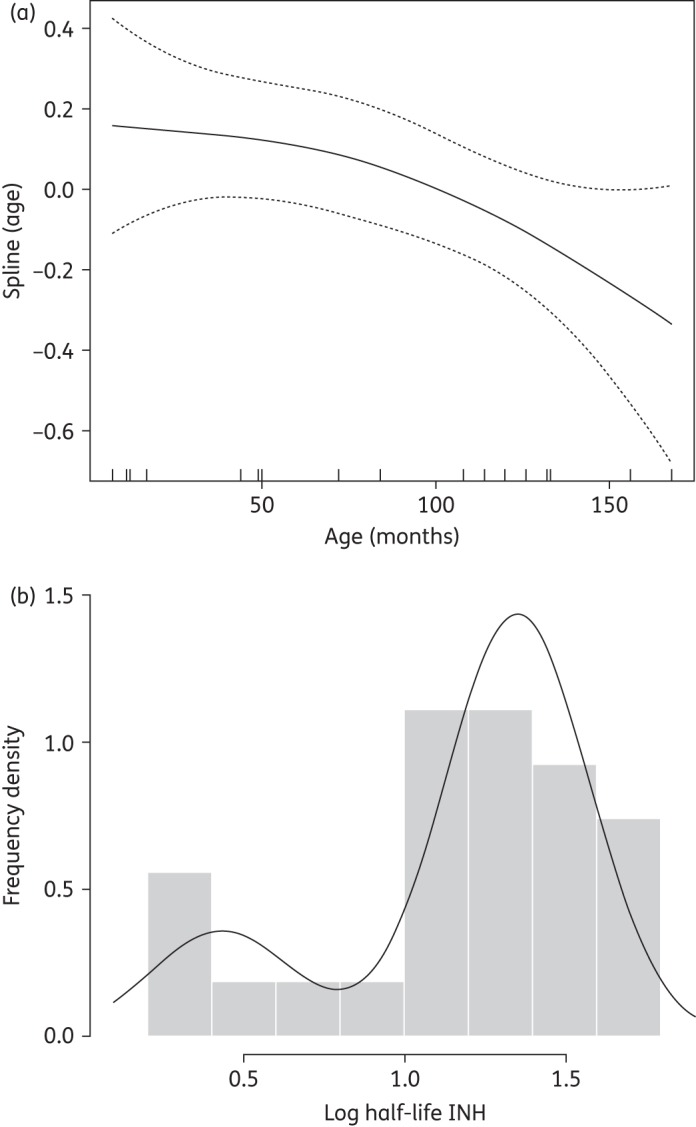
(a) Spline function of rifampicin CL/F with age derived from a generalized additive model (mean estimate shown by the continuous line and 95% Bayesian credible intervals shown by the broken lines). (b) Estimated frequency density of subpopulations of isoniazid CL/F within the dataset derived from empirical clustering analysis. INH, isoniazid.